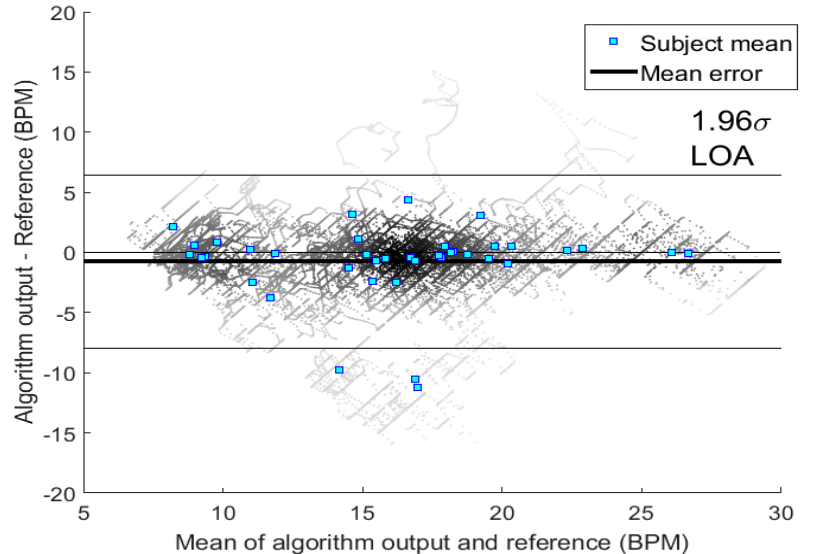
Figure 5. Bland-Altman plot for the WSST. The individual RR-results are represented by their density (Voronoi tessellation). The average values of the individual subjects are shown with blue squares. The three subjects outside the 1.96 σ limits are subjects 22, 31, and 34.